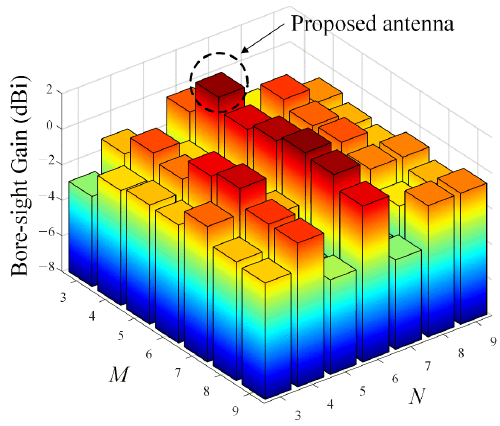
Figure 9. Bore-sight gain in accordance with variations of the number of reflectors.